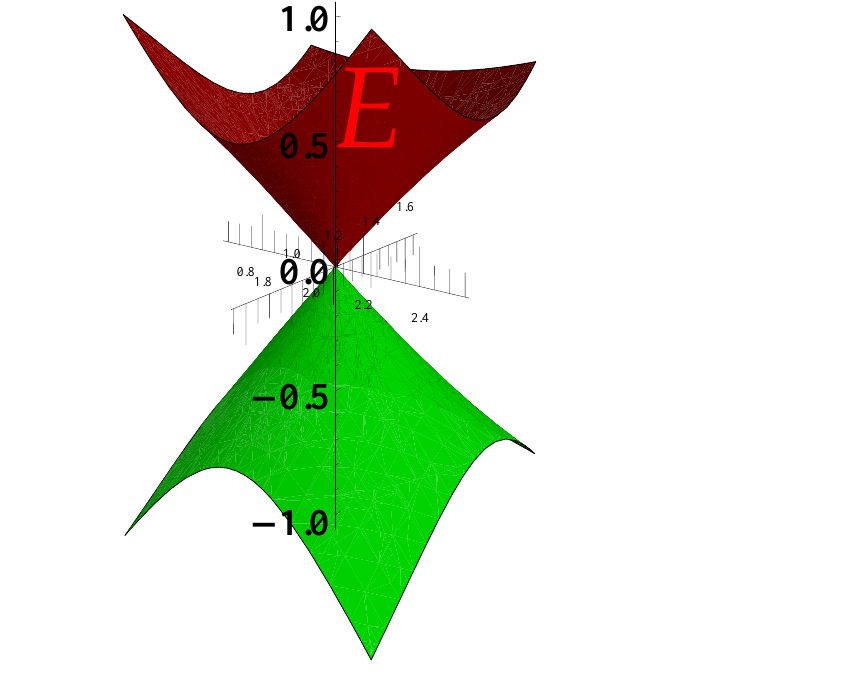
Figure 2. The linear dispersion relations near one of the Dirac points, showing the typical behavior of a relativistic-like system (the “ v F -light-cone” in k -space). Figure taken from